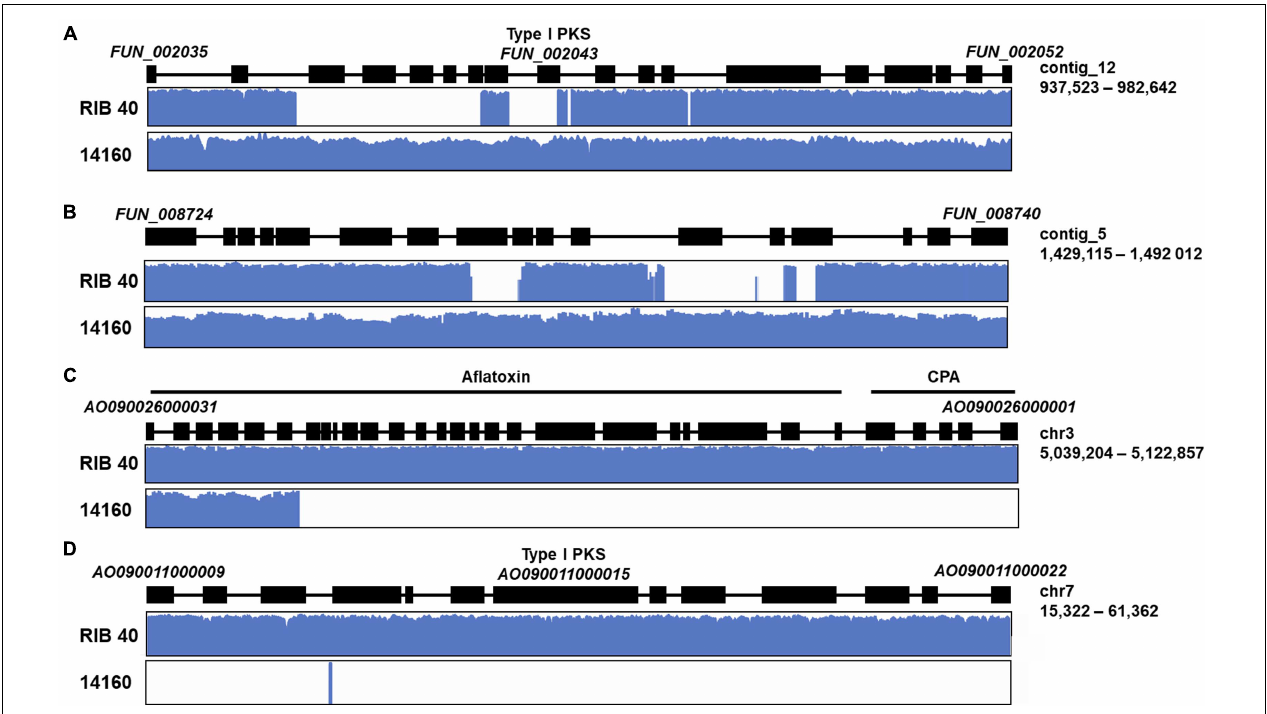
FIGURE 4 | Examples of lineage specific genes in secondary metabolite encoding gene clusters. Lineage specific genes with functional involvement in secondary metabolite production, regulation, and transport in A. oryzae 14160 (A,B) , and RIB 40 (C,D) . For each example, a schematic of the secondary metabolite encoding gene cluster is shown where black boxes represent genes. The first and last gene, scaffold/chromosome ID and scaffold/chromosome coordinates are labeled for each example. Graphs below the gene cluster schematic display the log10 read depth across the gene cluster for each